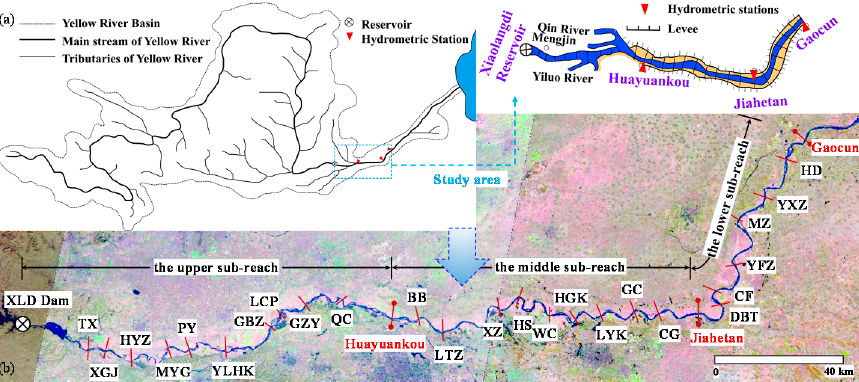
Figure 1. Maps of the Lower Yellow River: ( a ) Planview of the YR; and ( b ) Remote sensing image showing the braided reach in the LYR.